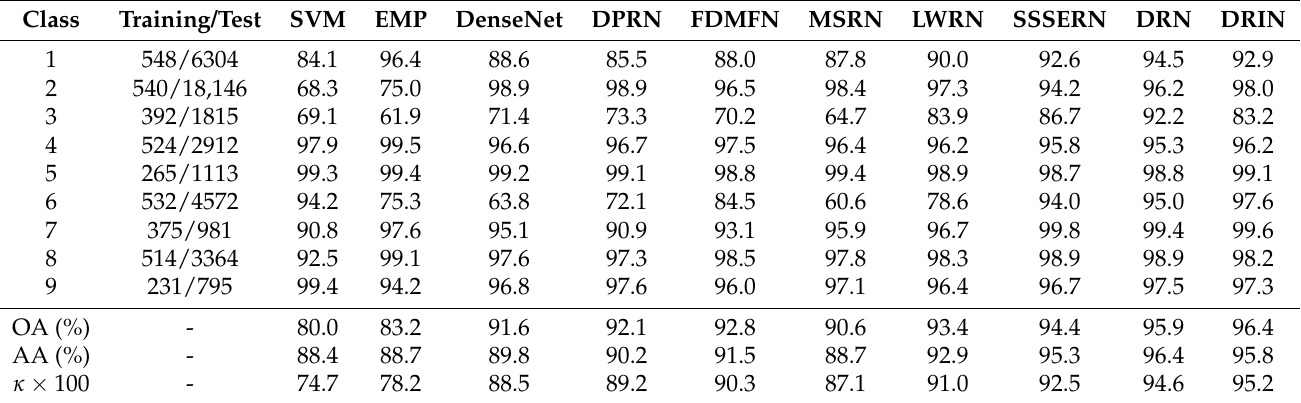
Table 9. Classification results for the UP